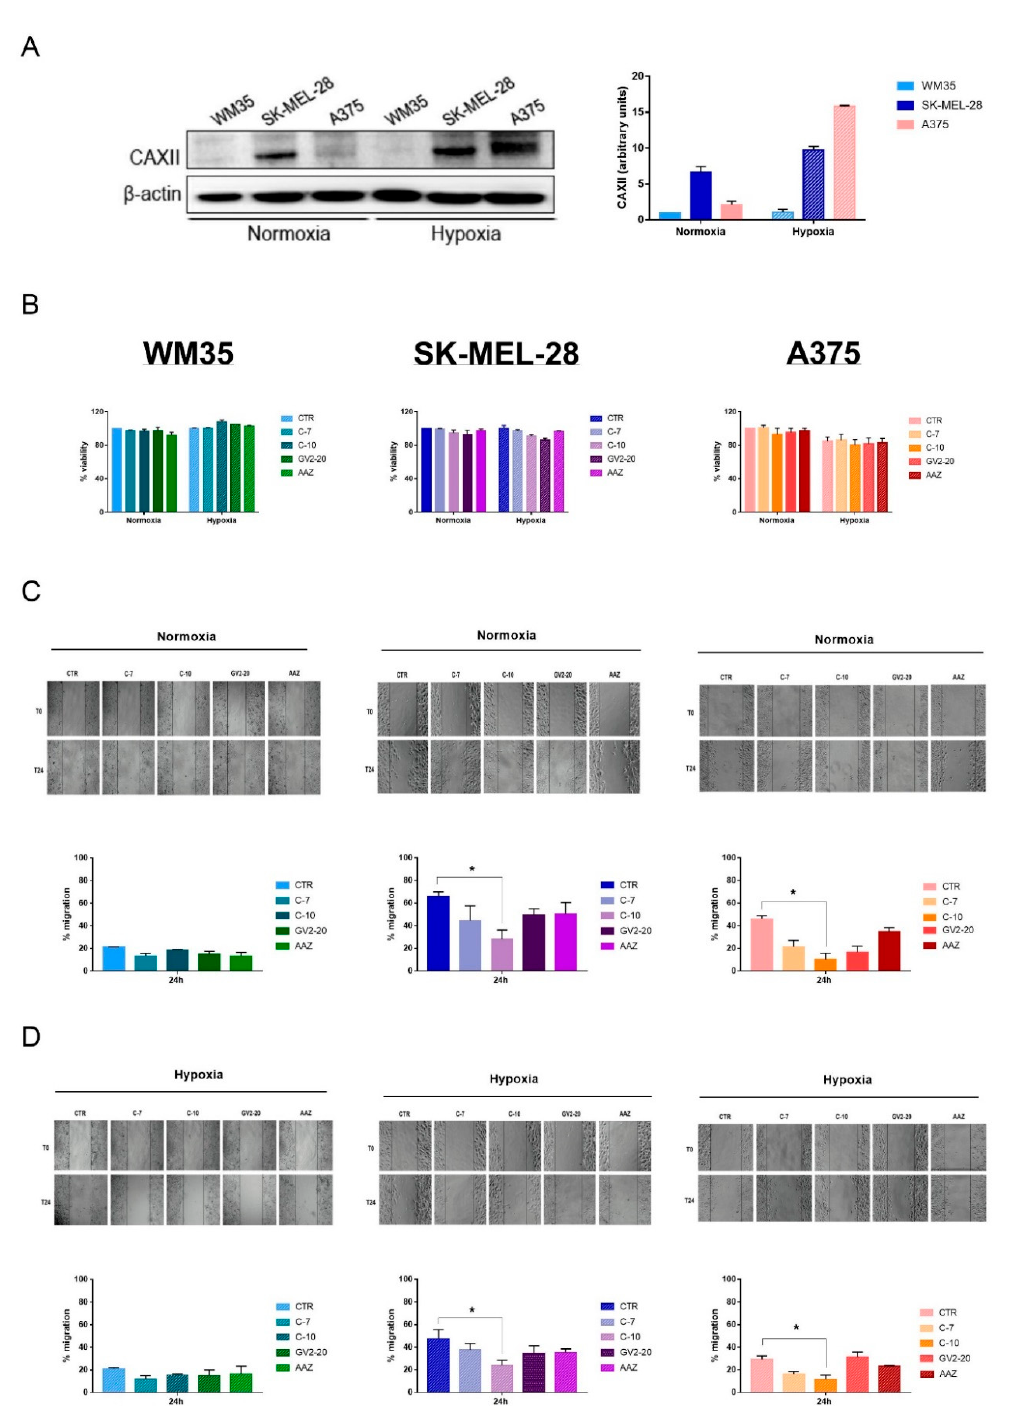
Figure 2. Effects of CAs inhibitors on cell migration. ( A ) CAXII protein expression in WM35, SK-MEL-28, and A375 under normoxia and hypoxia. Blot is a representation of the means and standard errors of the mean of three independent experiments. β -actin was used as loading control. ( B ) WM35, SK-MEL-28, and A375 viability assays after 72 h treatment with 10 nM of each compound and exposed to normoxia or hypoxia. Data are reported as the percentage of the ratio between the treated groups and controls. Graphs represent the means and standard errors of the mean of three independent experiments performed in triplicates. ( C ) WM35, SK-MEL-28, and A375 scratch assays after an overnight pretreatment and 24 h treatment with 10 nM of each compound and exposed to normoxia. Phase contrast microscopy images were taken with Olympus IX81 at a 10× magnification. Data are represented as the percentage of migration rate between treated groups and controls. Graphs represent the